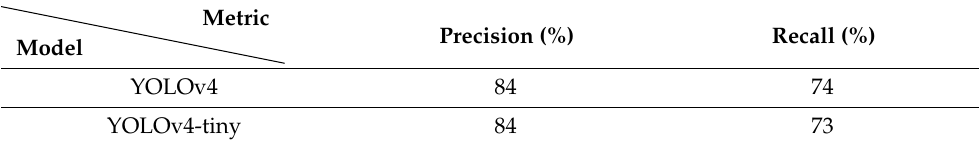
Figure 7. Outputs obtained YOLOv4-tiny running 6000 epochs using 720 × 720 images. Table 2. Precision and recall values of YOLOv4 and YOLOv4-tiny